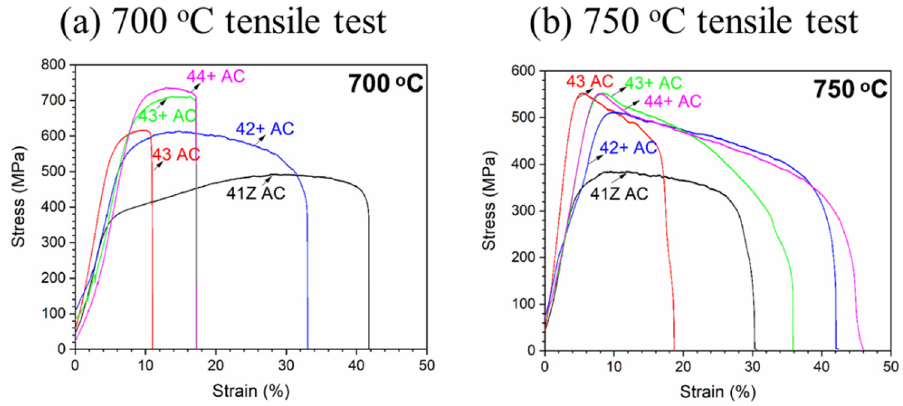
Figure 6. Tensile test results of the model alloys in as-cast condition at ( a ) 700 °C and ( b ) 750 °C.